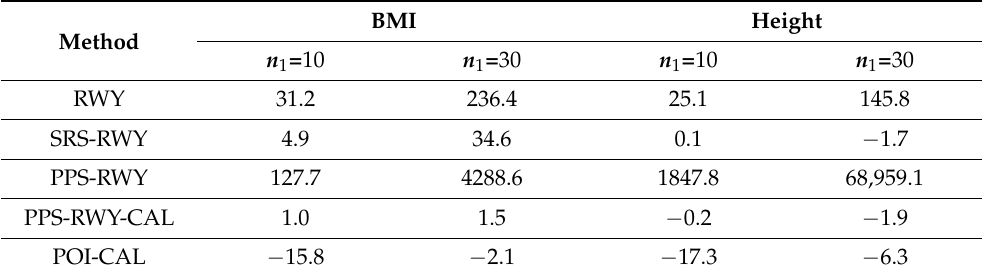
Table 2. The percent relative biases of the bootstrap variance estimators.